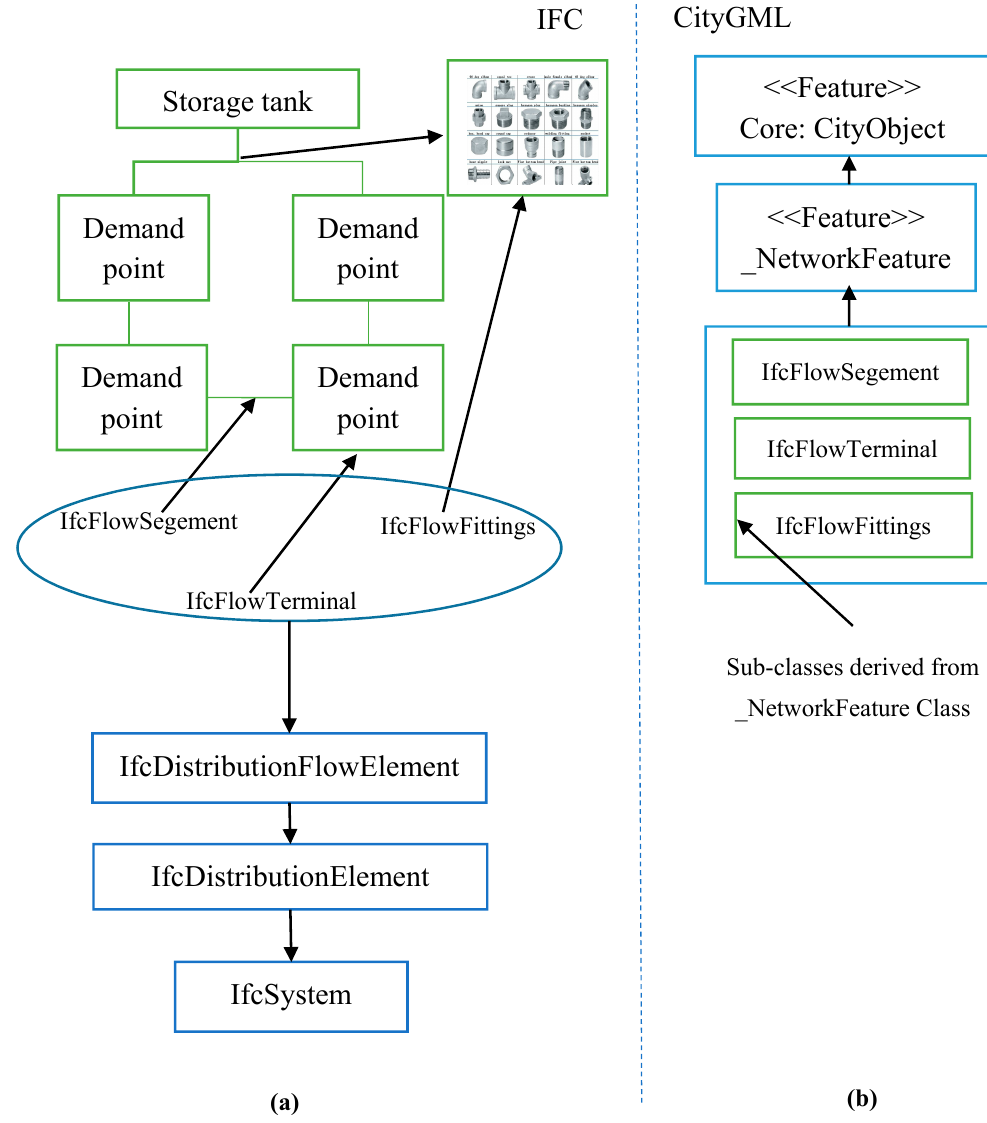
Figure 2. ( a ) Pipe elements represented in Industry Foundation Classes (IFC) schema; ( b ) pipe elements represented in City Geography Markup Language (CityGML) Figure 2. (a) Pipe elements represented in Industry Foundation Classes (IFC) schema; (b) pipe elements represented in City Geography Markup Language (CityGML) schema.